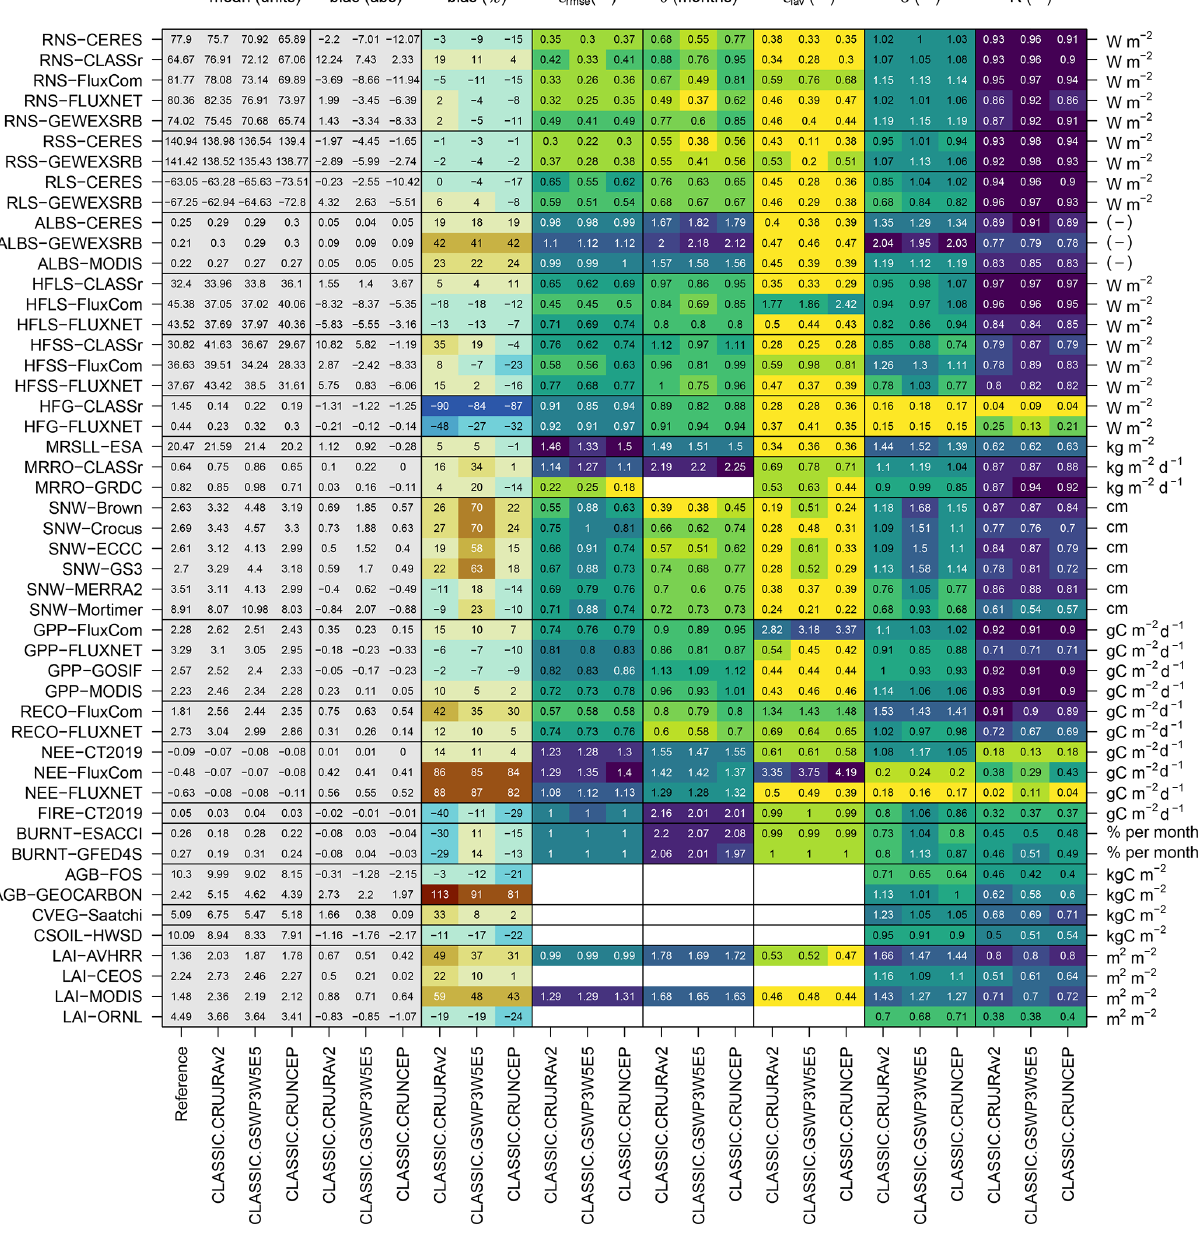
Figure 5. Global mean values of statistical metrics defined in Sect. 2. The color ranges span the minimum and maximum for each metric. The physical units of the mean and absolute bias are given by the vertical axis on the right-hand